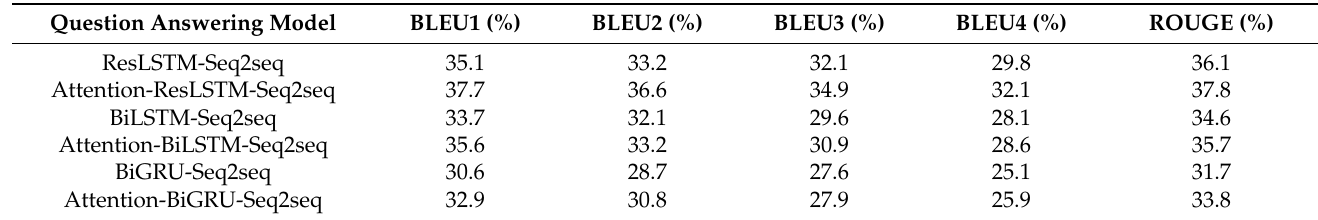
Figure 8. Training set loss rate of rice-related knowledge Q&A model trend chart. Table 6. BlEU and ROUGE comparison of different deep learning Q&A models.